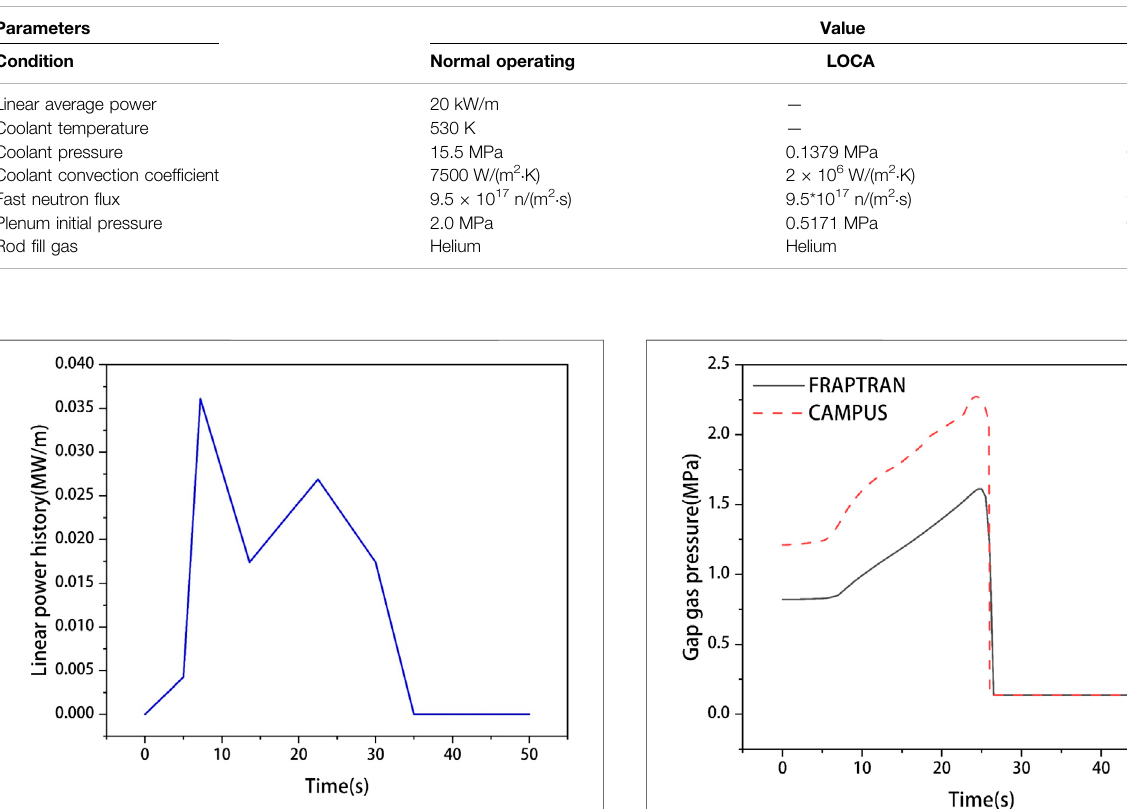
TABLE 2 | Input parameters for normal operating and accident conditions.